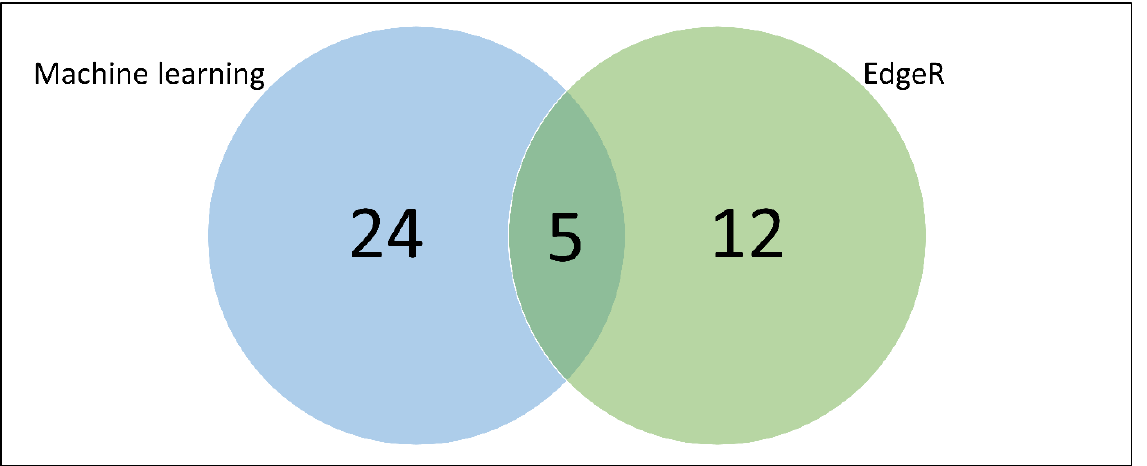
Figure 4. Venn diagram of the DEMi candidates identified using edgeR and the machine learning approach.